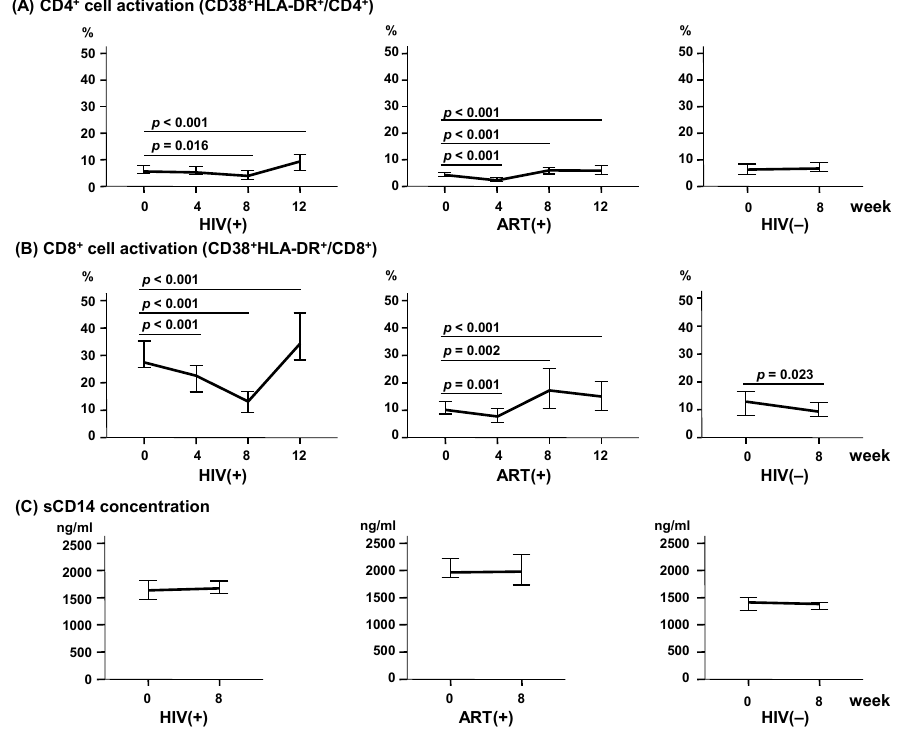
Figure 3. Change of cell activation after LcS ingestion in each study group. ( A ) Percentage of activated CD4 + cells (CD38 + HLA-DR + /CD4 + ); ( B ) Percentage of activated CD8 + cells (CD38 + HLA-DR + /CD8 + ); ( C ) Plasma sCD14 concentration (monocyte activation status). Bars represent the median and 95% confidence interval for each group. The p values show the comparison of weeks 4, 8, and 12 to week